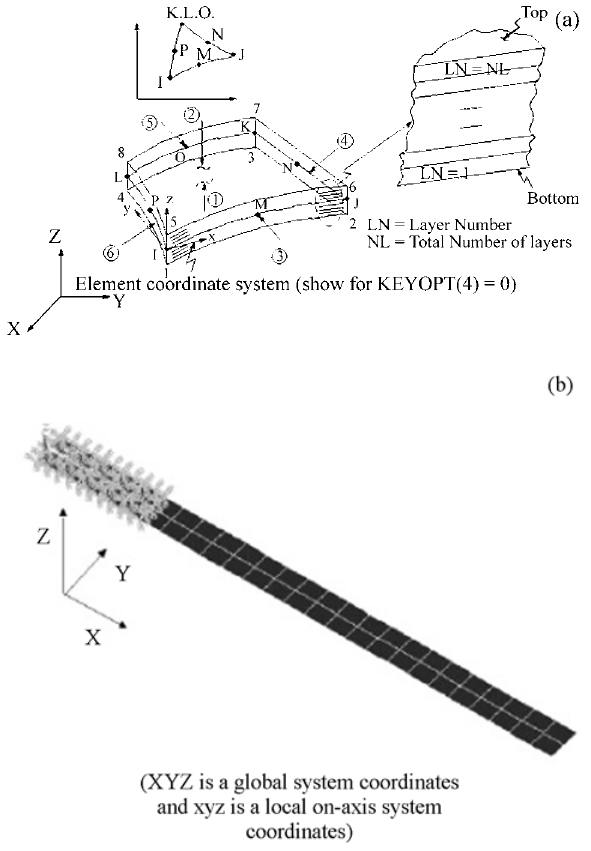
Figure 1. Element shell99 and cantilever beam model (Ansys 25